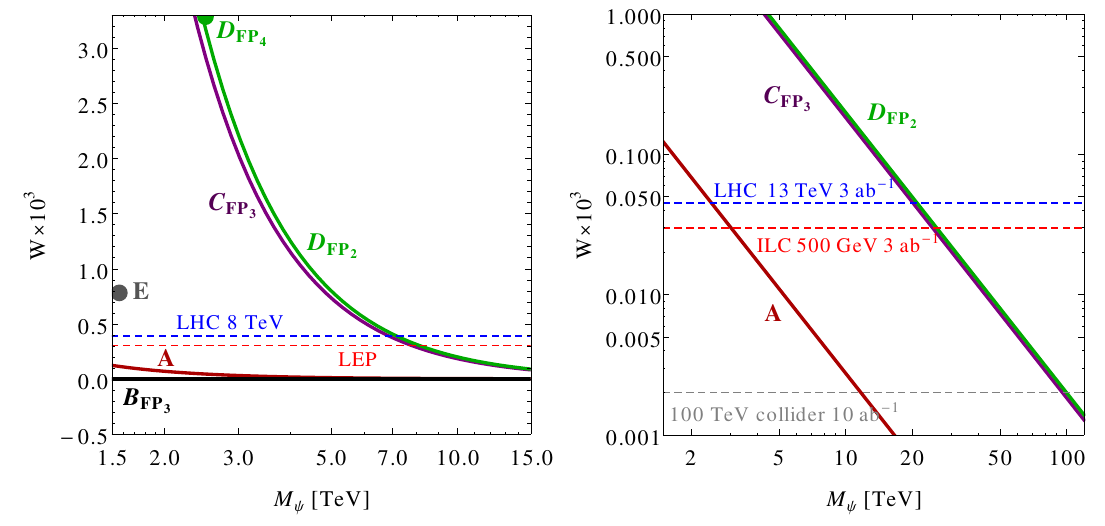
Figure 18 . Shown is the electroweak precision parameter W (5.4) as a function of the BSM fermion mass for the low-scale benchmark models given in table 7. In the left panel dashed lines show 95% C.L. upper limits obtained from LEP (red) and the LHC at 8 TeV (blue). In the right panel dashed lines indicate the projected reach of the LHC at 13 TeV (blue), the ILC 500 GeV (red), and a 100 TeV collider (gray). Experimental limits are taken from